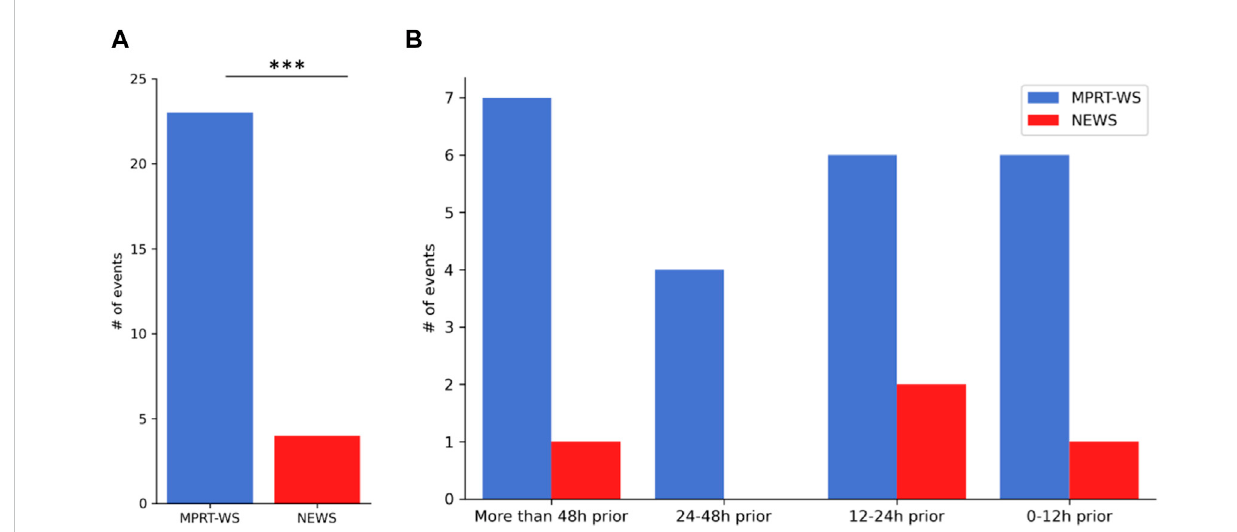
FIGURE 4 The number of “ High ” and “ Urgent ” events detected using the new warning tool before overt clinical deterioration. 39 patients had clinical deterioration. 30 patients of them received ‘ High ’ or ‘ Urgent ’ using the MPRT-WS, and in 23 (A) patients of these 30 that initiated an alarm, the